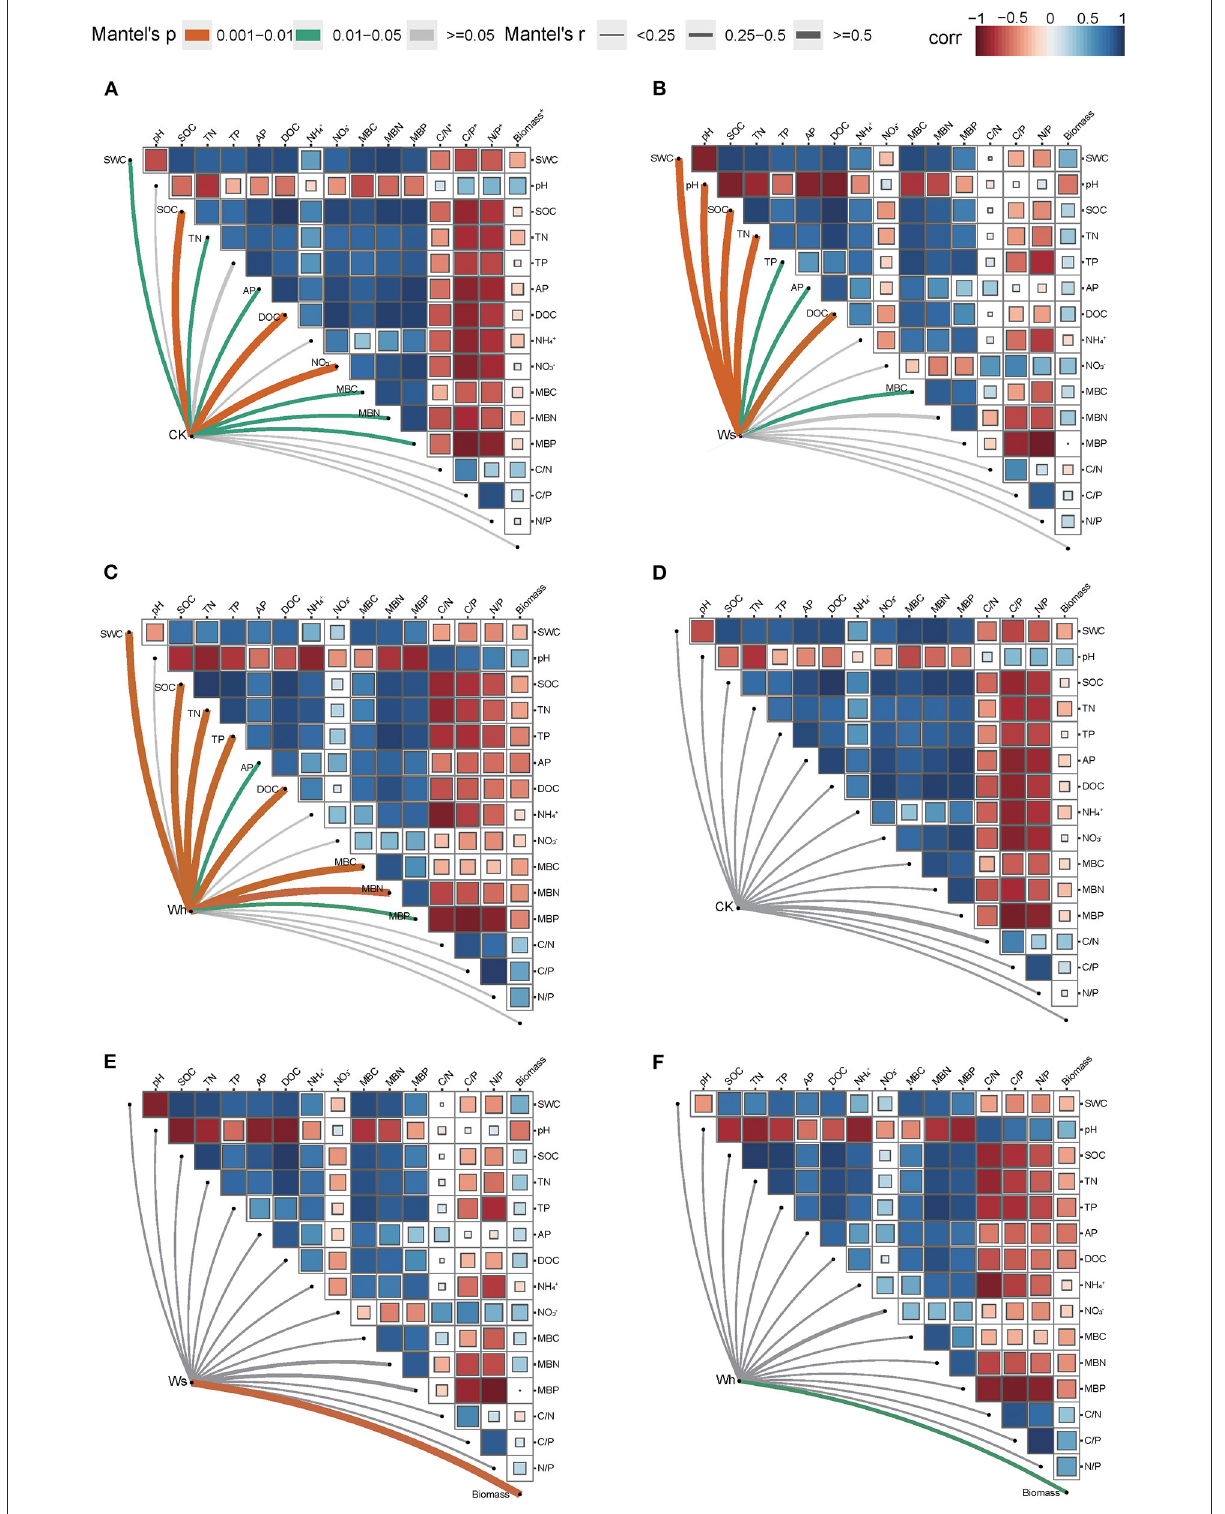
FIGURE4 Mantel tests between the vertical structure of soil bacterial (A–C) and fungal (D–F) communities with environmental factors. Ws, slight warming; Wh, high warming; MBC, microbial biomass carbon; MBN, microbial biomass nitrogen; MBP, microbial biomass phosphorous; C/N*, MBC/MBN; C/P*, MBC/MBP; N/P*, MBN/MBP; Biomass*, plant